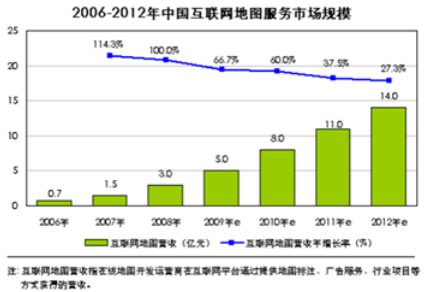
Figure 1 ． 2006-2012 China online map service market scale